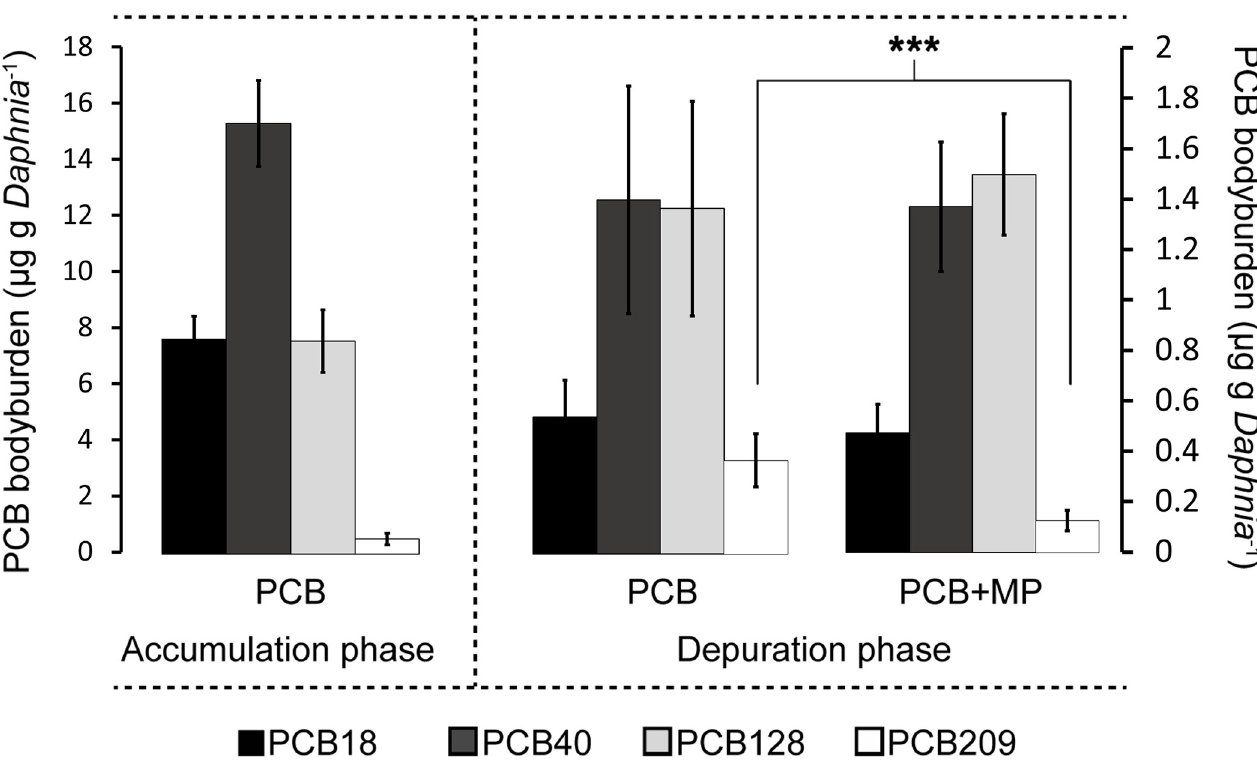
Fig 1. PCB Concentrations in D . magna before and after depuration. PCB concentrations (mean ± SD) in D . magna at the end of the accumulation (day 3, left y-axis), and depuration (day 7, right y-axis) phases; note the differently scaled y-axes. The concentration of PCB 209 was lower in the PCB+MP treatment compared to the PCB treatment (Welch’s Two Sample t-test, t 11 = 5.6, p < 0.001). See also Table